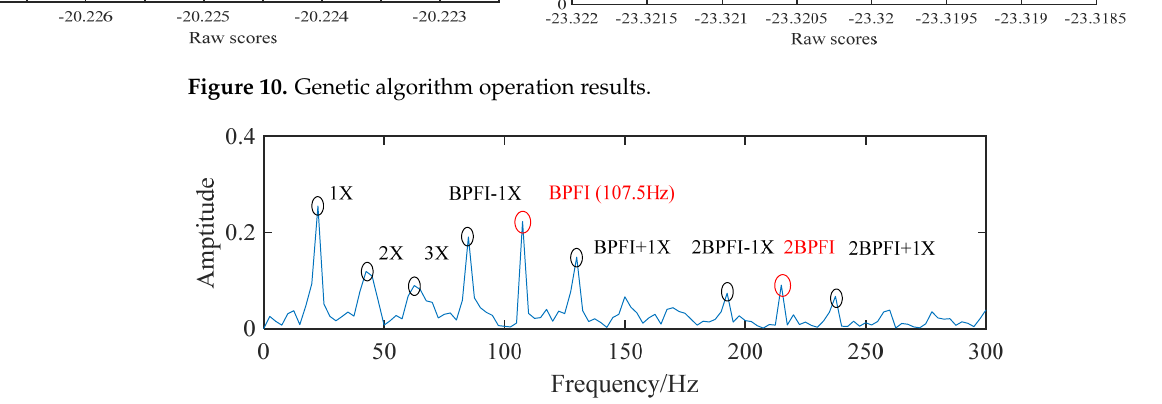
Figure 11. The envelope spectrum of the signal after denoising. Table 4. Comparison of noise reduction effect of actual bearing.